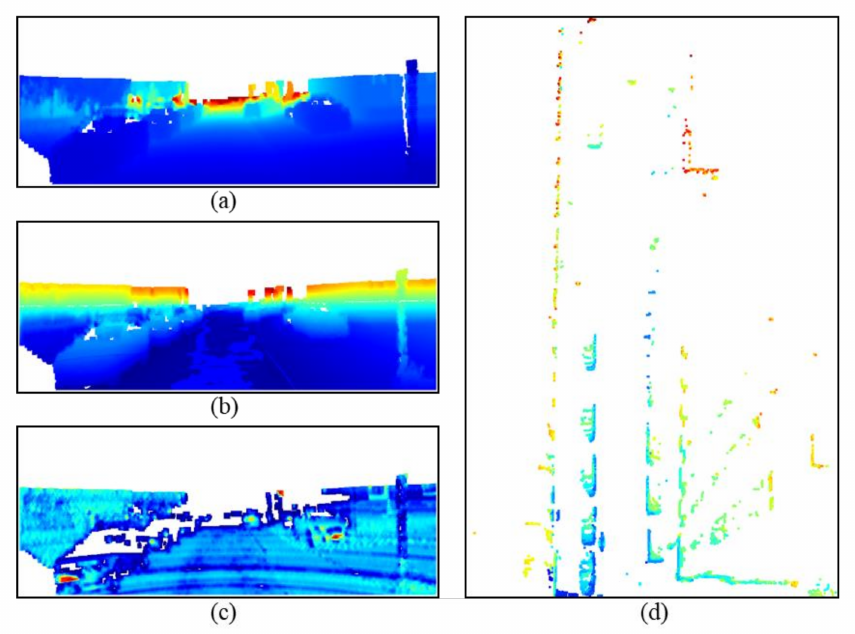
Figure 1. RGB image and PCD map in FV and BEV: ( a ) RGB image, ( b ) LiDAR depth map in FV, ( c ) LiDAR height map in FV, ( d ) and LiDAR height map in